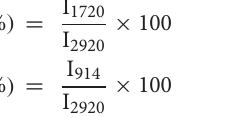
Frontiers in Materials |